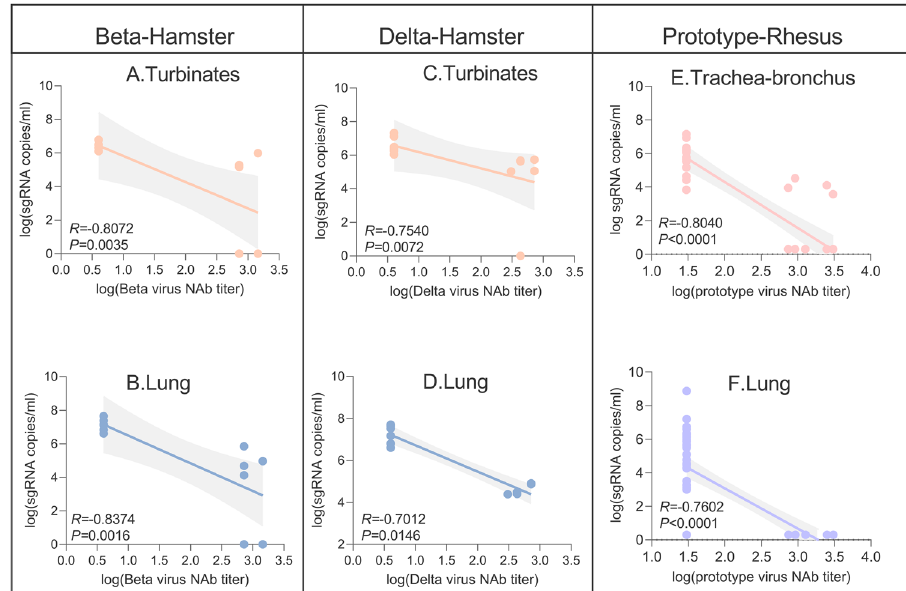
Fig. 9 Antibody correlates of protection in hamsters and rhesus macaques. Correlation between nasal turbinates ( A ) and lung ( B ) viral loads with and Beta nAb titers, and between nasal turbinates ( C ) and lung ( D ) viral loads and Delta nAb titers in hamsters. Correlation between trachea-bronchus ( E ) and lung ( F ) viral loads and prototype virus nAb titers in rhesus macaques. Three important parameters from the correlates analysis shown as R -value, P -value and 95% con fi dence intervals. Shaded areas represent 95% con fi dence